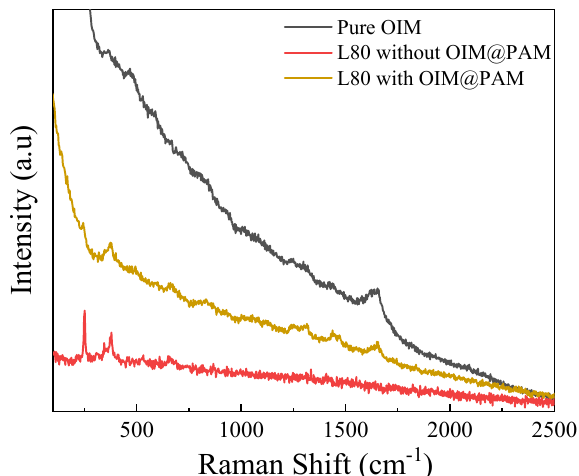
Figure 11. Raman spectrum of pure OIM and L80 immersed in 3.5 wt.%NaCl with and